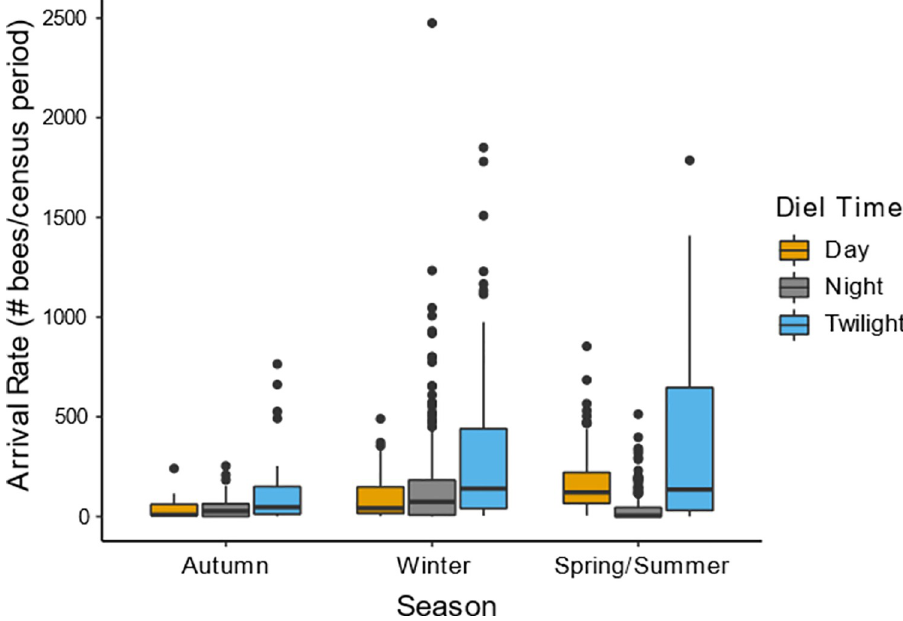
Fig 7. Arrival rates across seasons. Boxplots showing arrival rates during each diel time across seasons are shown. Nocturnal arrival rates were higher and diurnal arrival rates were lower in winter compared to spring/summer ( P < 0.05), but did not differ between autumn and spring/summer or autumn and winter ( P > 0.05). In both winter and spring/summer arrival rates were significantly different between every diel time, with twilight having the highest rates. Arrival rates were higher at night than during the day in winter ( P < 0.05), which was not seen in any other season. Arrival rates during twilight was also higher than the nocturnal arrival rate in autumn ( P < 0.05), but the arrival rates during twilight did not significantly differ between seasons ( P > 0.6). The significance of all pairwise differences can be found in Table E in S1 File. Data shown here includes all observations from all five focal colonies studied over the course of the